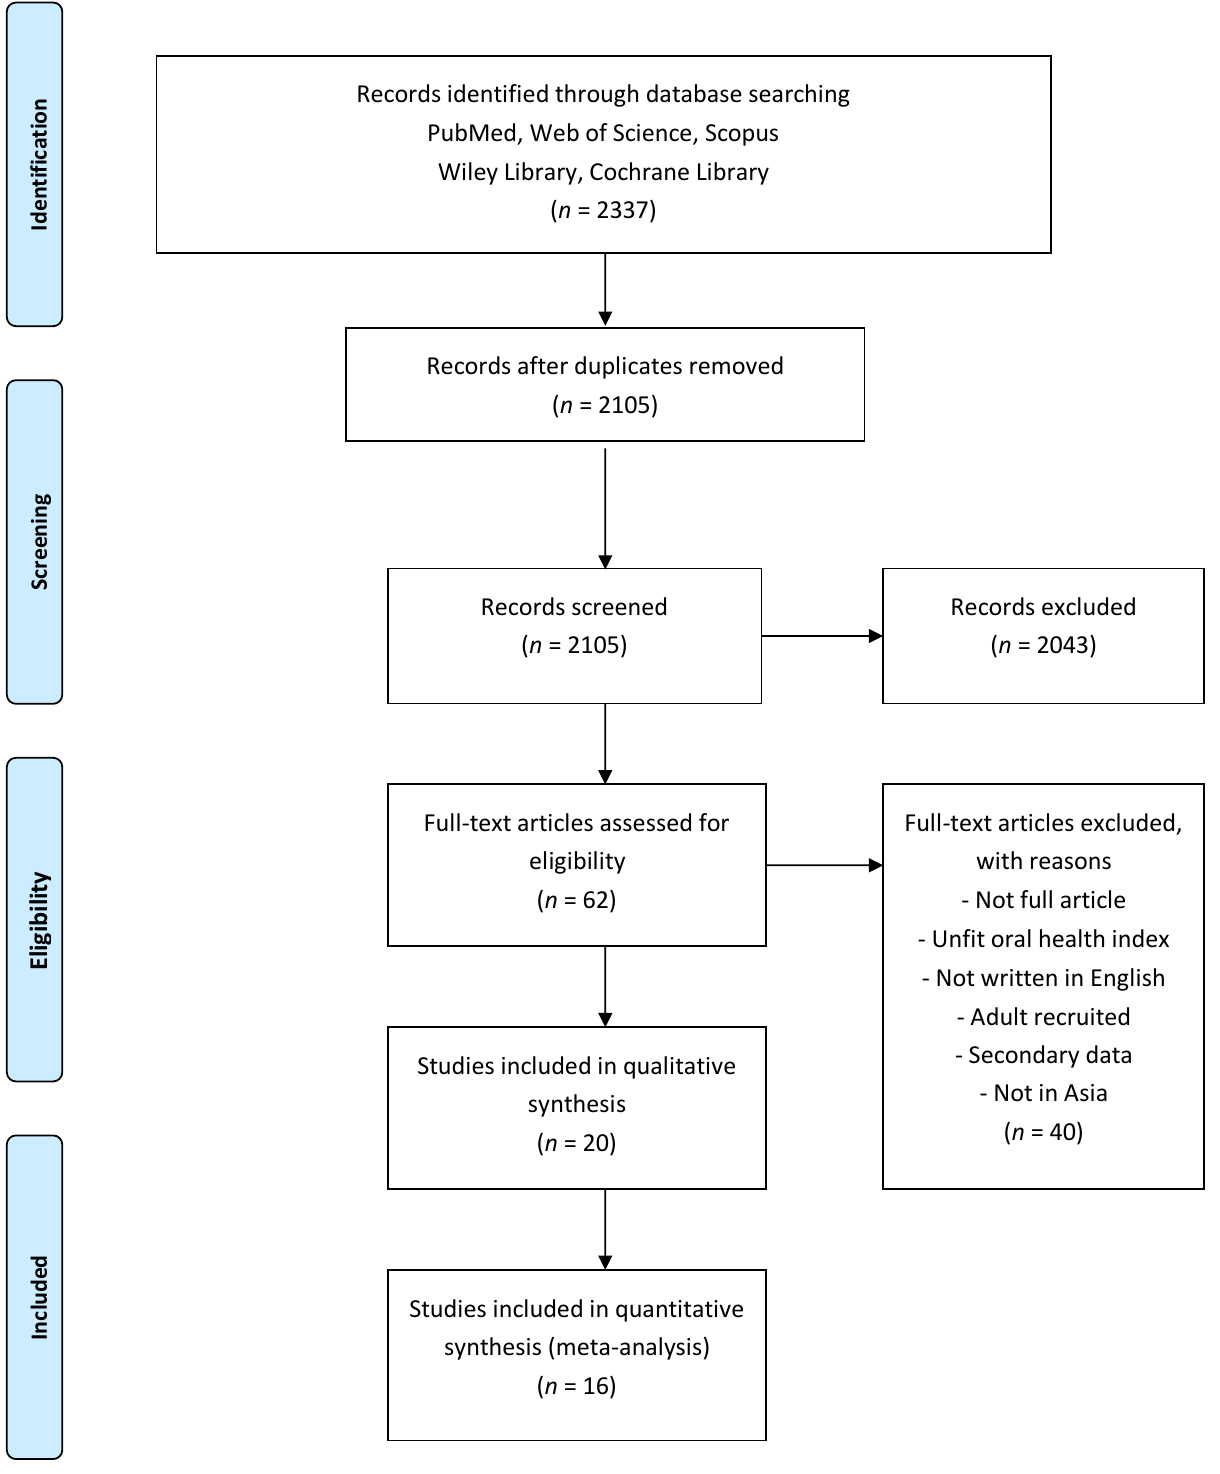
Figure 1. The PRISMA flow chart. There were 2337 articles identified from the web database and 2105 articles were left after duplicate removal. After the article appraisal procedure, 20 articles were left for systematic review, and 16 articles left for meta-analysis.